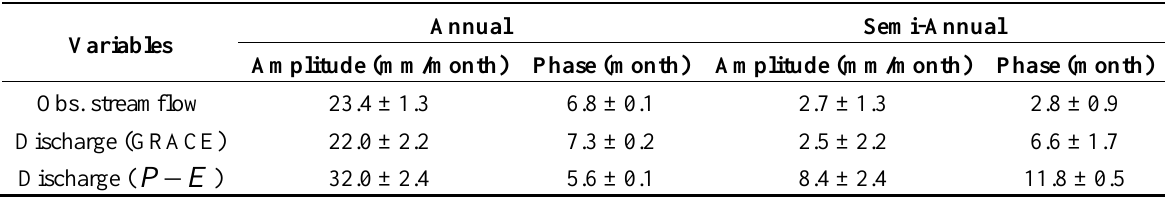
Table 1. Coefficients for least squares best fit over the time window of February 2002 to December 2009 with confidence level of